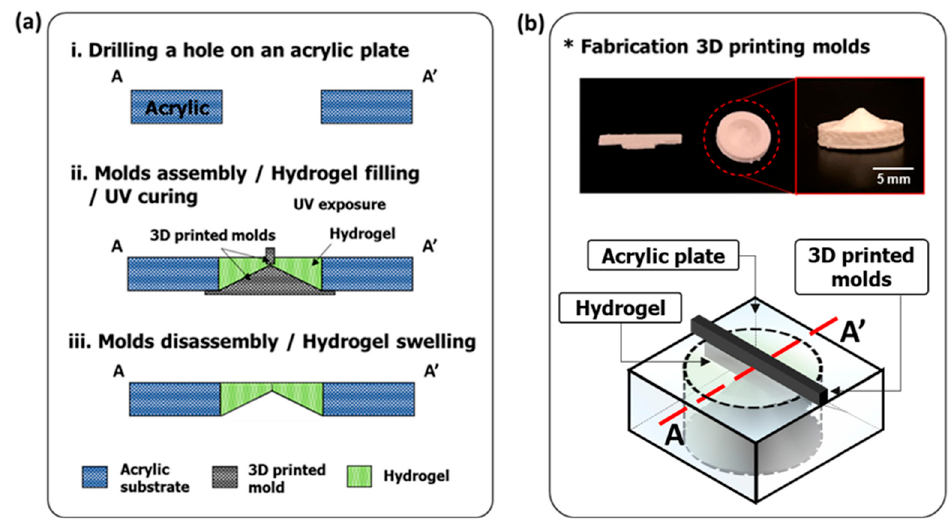
Figure 8. ( a ) Fabrication process: i. Drilling a hole in the center of an acrylic plate. ii. 3D printed molds are assembled in the hole, then the prepared hydrogel solution is poured and cured by UV light (365 nm, 400 mJ/cm2). iii. The 3D printed molds are disassembled and the device is immersed in water to swell the hydrogel. ( b ) The actual 3D printed molds and illustration of the parts assembled for the device fabrication.